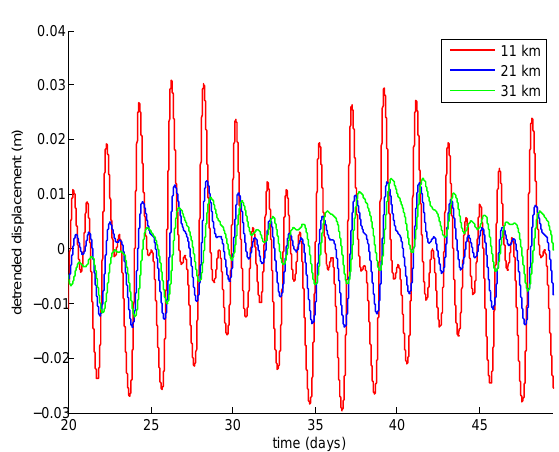
Fig. 6. Linearly detrended horizontal surface displacement. The model was forced with ocean tides using only the O1 and the K1 tidal components, each with an amplitude of 2m. Apart from the difference in ocean tidal forcing, all parameters are identical to those used in Fig. (5).